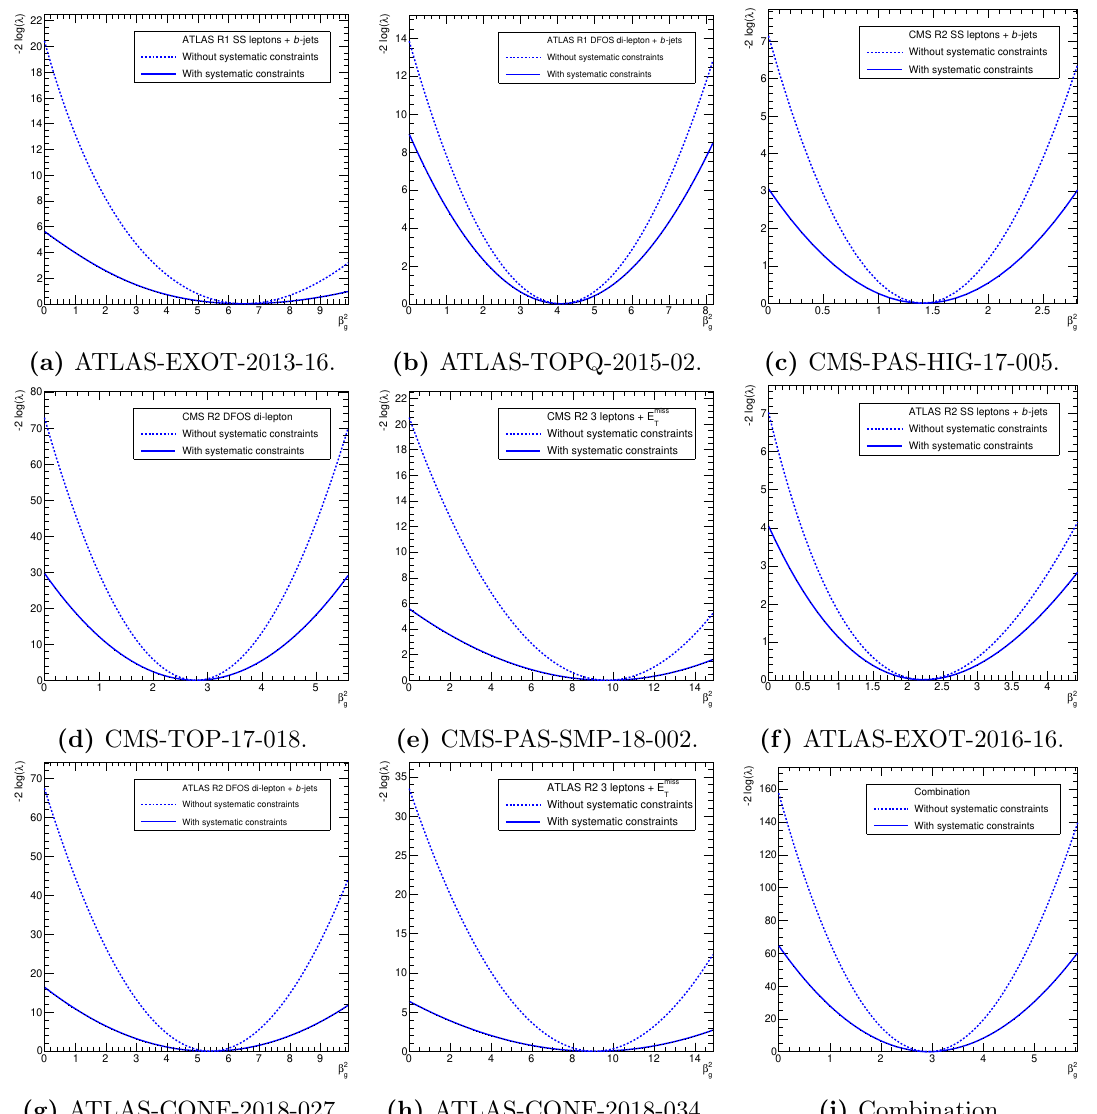
Figure 13 . The pro(cid:12)le likelihood ratio overlaid with the NLL for each of the (cid:12)t results performed in this article. These (cid:12)gures provide a good reference for how the systematic uncertainties a(cid:11)ect the signi(cid:12)cance of the obtained (cid:12)t